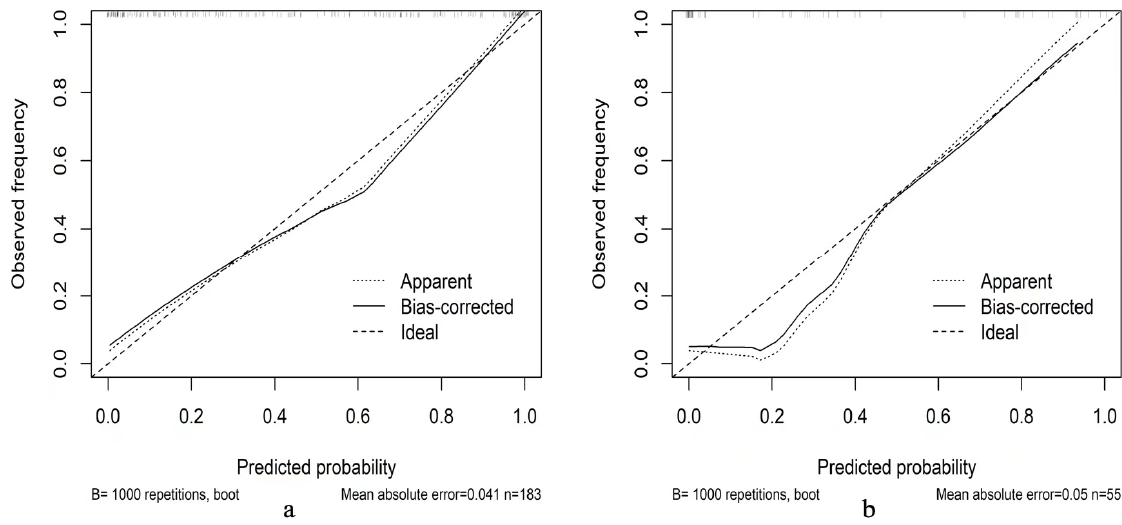
Figure 5. Calibration curve of the nomogram in the training ( a ) and test ( b ) groups.